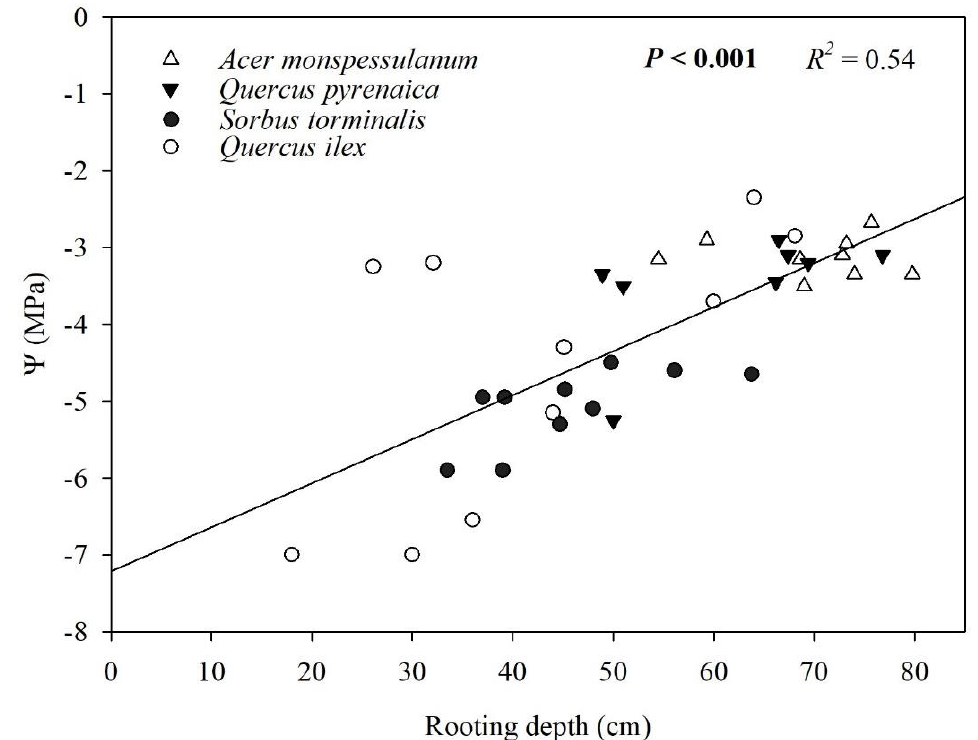
Figure 5. Linear regression between the predawn water potential ( ψ ) and rooting depth at the end of the study (week 11) in four broadleaf Mediterranean tree species growing in rhizotrons. Each point represents the data from an individual.